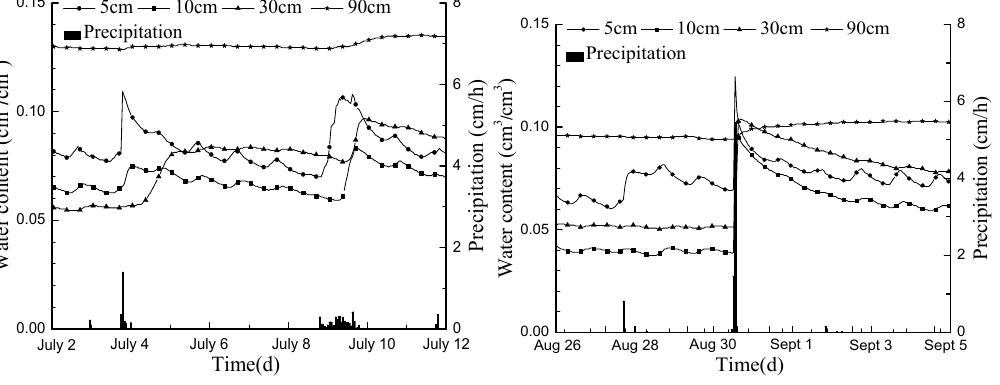
Figure 4. Water content and precipitation in 2014.